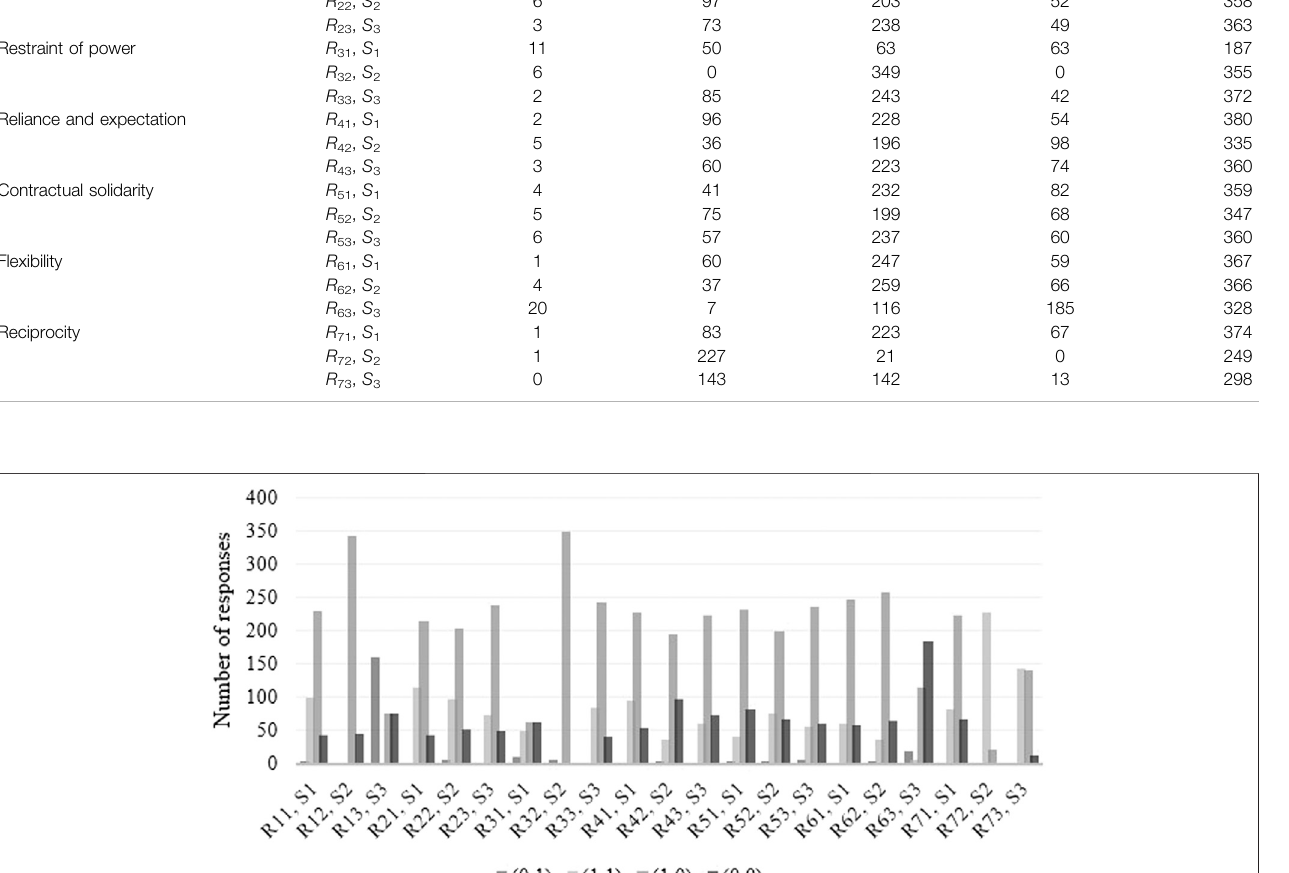
Frontiers in Built Environment |